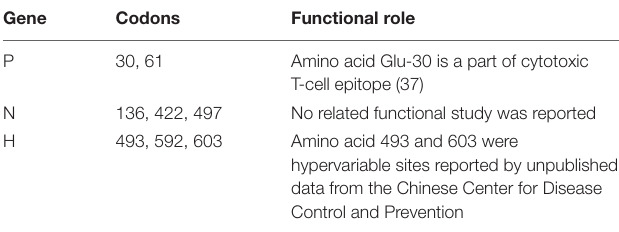
TABLE 3 | Gene-wide distribution of codons under pervasive